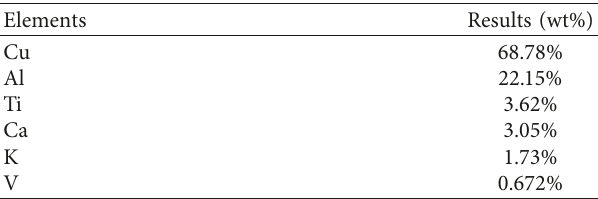
Table 4: Copper electrode in titanium parent material.